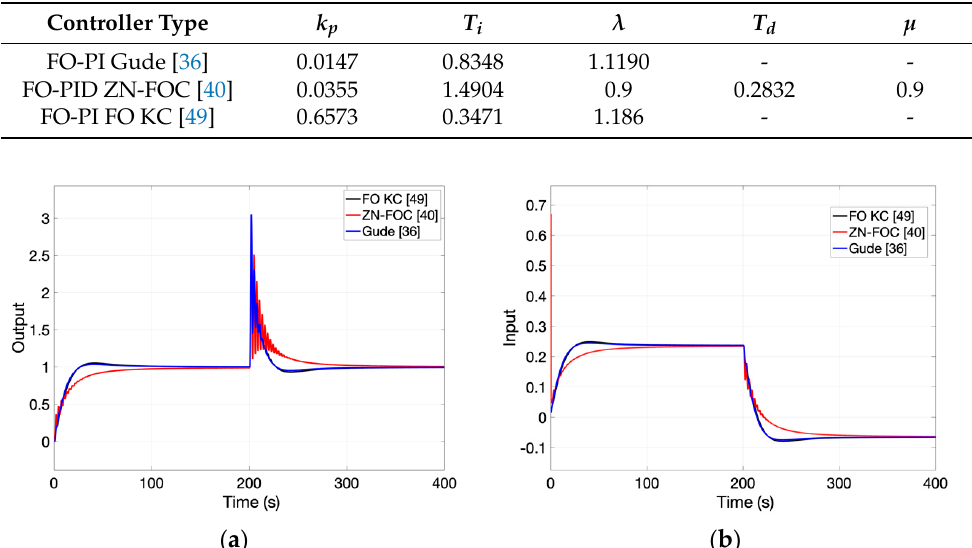
Table 10. FO-PID parameters computed for the poorly damped process. Table 11. Closed-loop results obtained with the FO-PID controller for the poorly damped process.